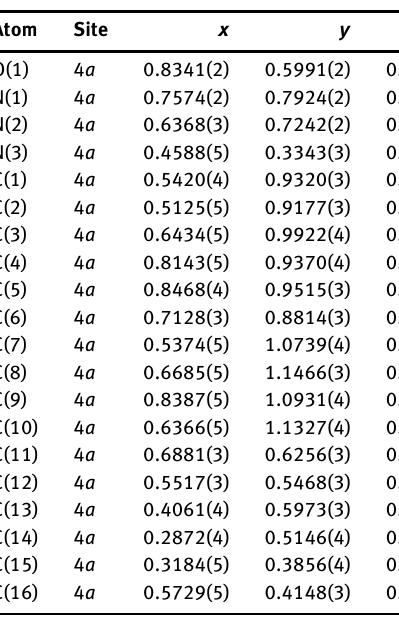
Table 3: Atomic coordinates and displacement parameters (Å 2